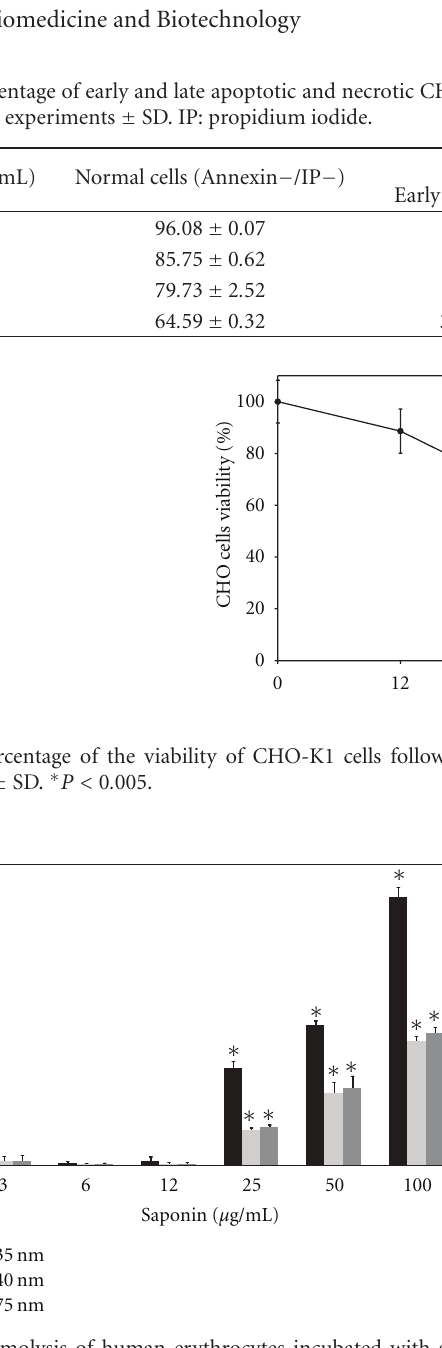
Figure 2: Hemolysis of human erythrocytes incubated with sap- onin. Hemolysis was measured at 435, 540, and 570 nm; mean of three independent experiments ± SD. ∗ P < 0 .